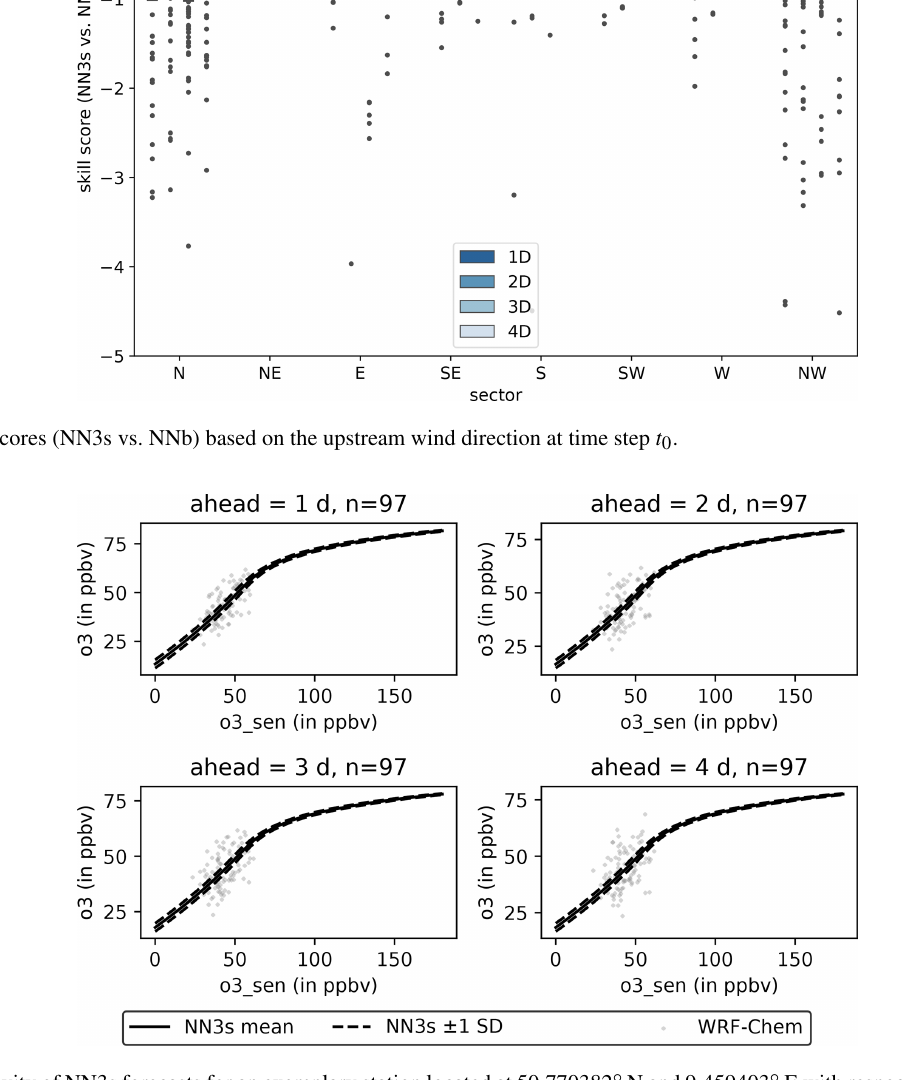
Figure 11. Sensitivity of NN3s forecasts for an exemplary station located at 50 . 770382 ◦ N and 9 . 459403 ◦ E with respect to ozone. Light grey dots (97) represent each sample’s daily aggregated WRF-Chem values at time step t 0 . The solid black line represents the mean sensitivity across all samples, and the dashed black lines represent ± 1 standard deviation, respectively. Sensitivities are shown individually for all lead times (1 to